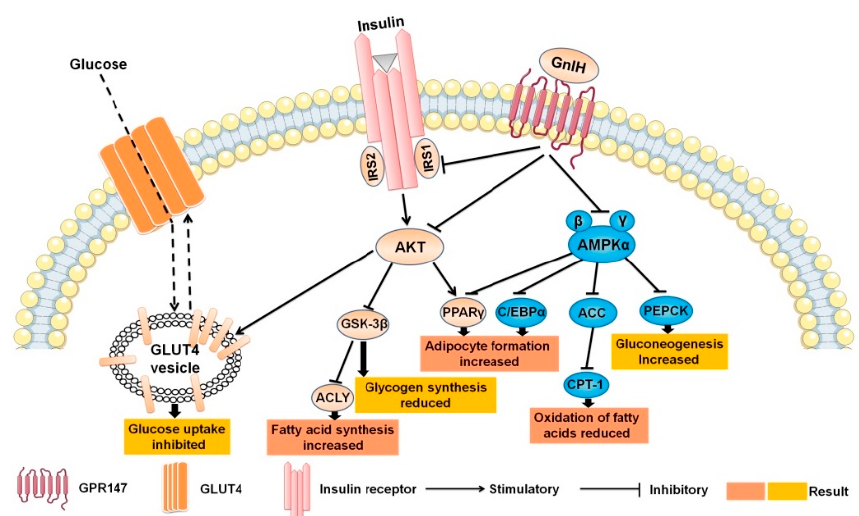
Figure 8. Effects of intraperitoneally injected GnIH on related mechanisms of glucolipid metabolism .